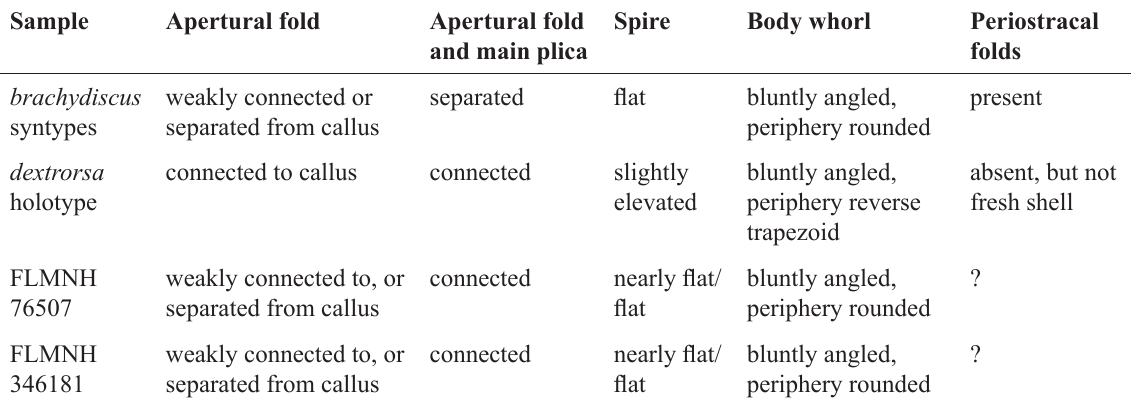
Table 2. Variable shell traits of populations of Chersaecia dextrorsa (Benson, 1860).